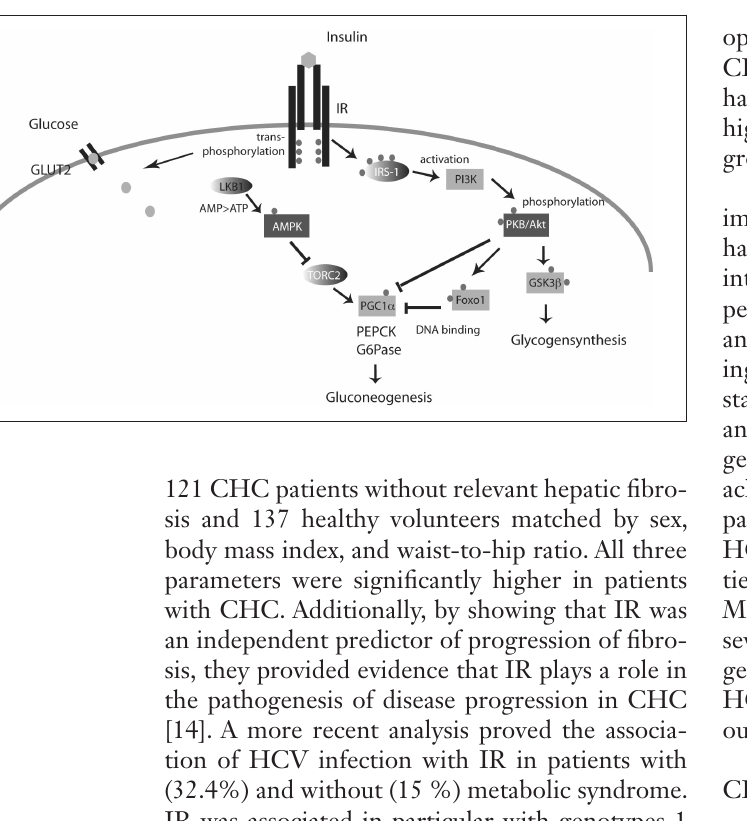
The insulin signalling cascade. Insulin binds to the hepatic insulin receptor and acti- vates the insulin signalling cascade, resulting in activation of glycogen synthesis from glucose and inhibition of gluconeogenesis from amino acids. ( → , positive association, , negative association/inhibition) Abbreviations: AMPK, AMP activated protein kinase, Foxo1, forkhead transcription factor 1, GLUT2, glucose transporter 2, G6Pase, glucose-6-phosphatase, GSK3 β , glycogen synthase kinase 3 β , IR, insulin receptor, IRS-1, insulin receptor substrate 1, PEPCK, phosphoenolpyruvate- carboxykinase, PGC1 α , peroxisome proliferator-activated receptor 1 α , PI3K, phos- phatidyl-inositol-3-kinase, PKB/Akt, protein kinase B, TORC2, transducer of regulated CREB activity